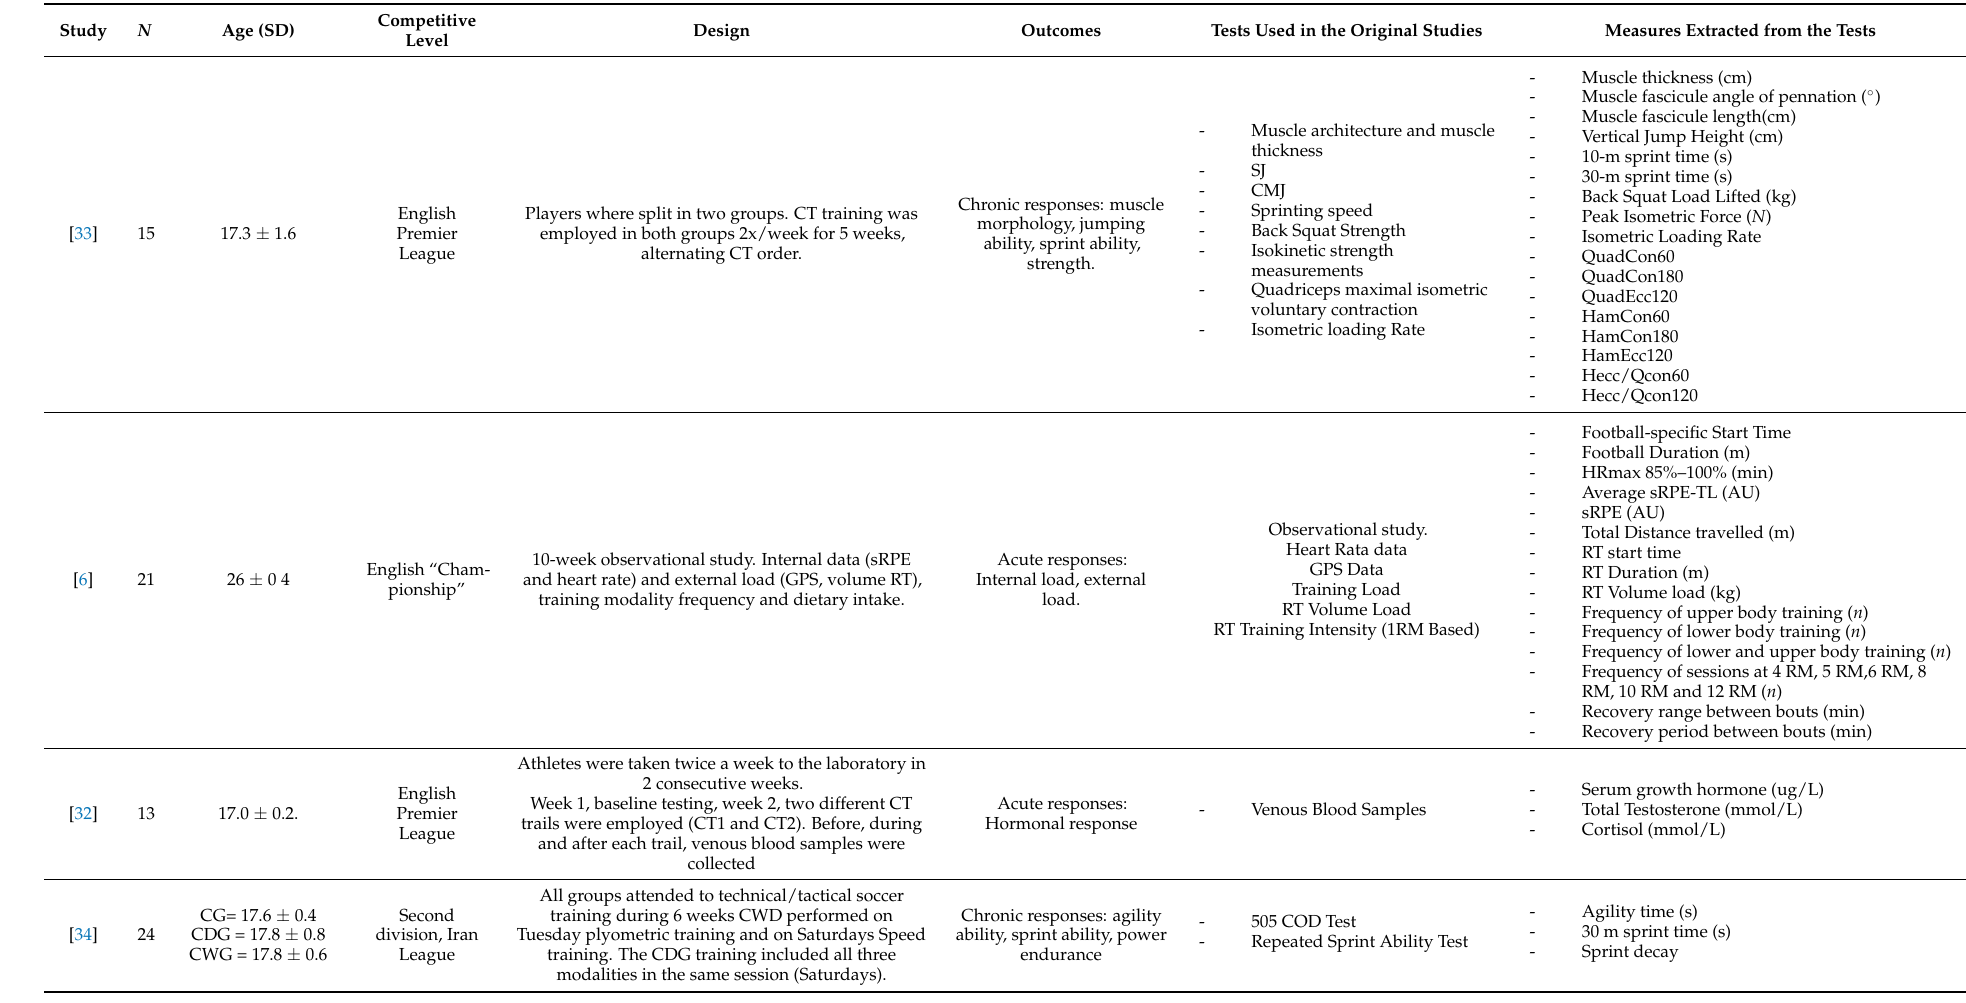
Table 2. Characteristics of the included